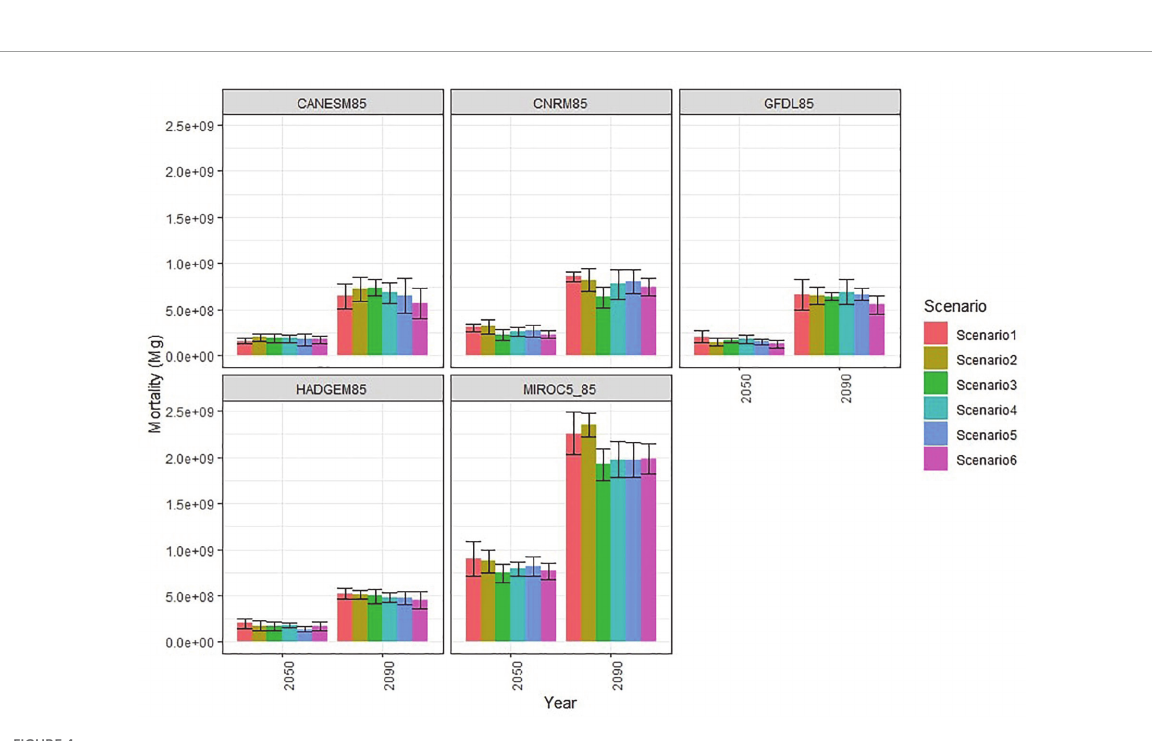
Frontiers in Forests and Global Change